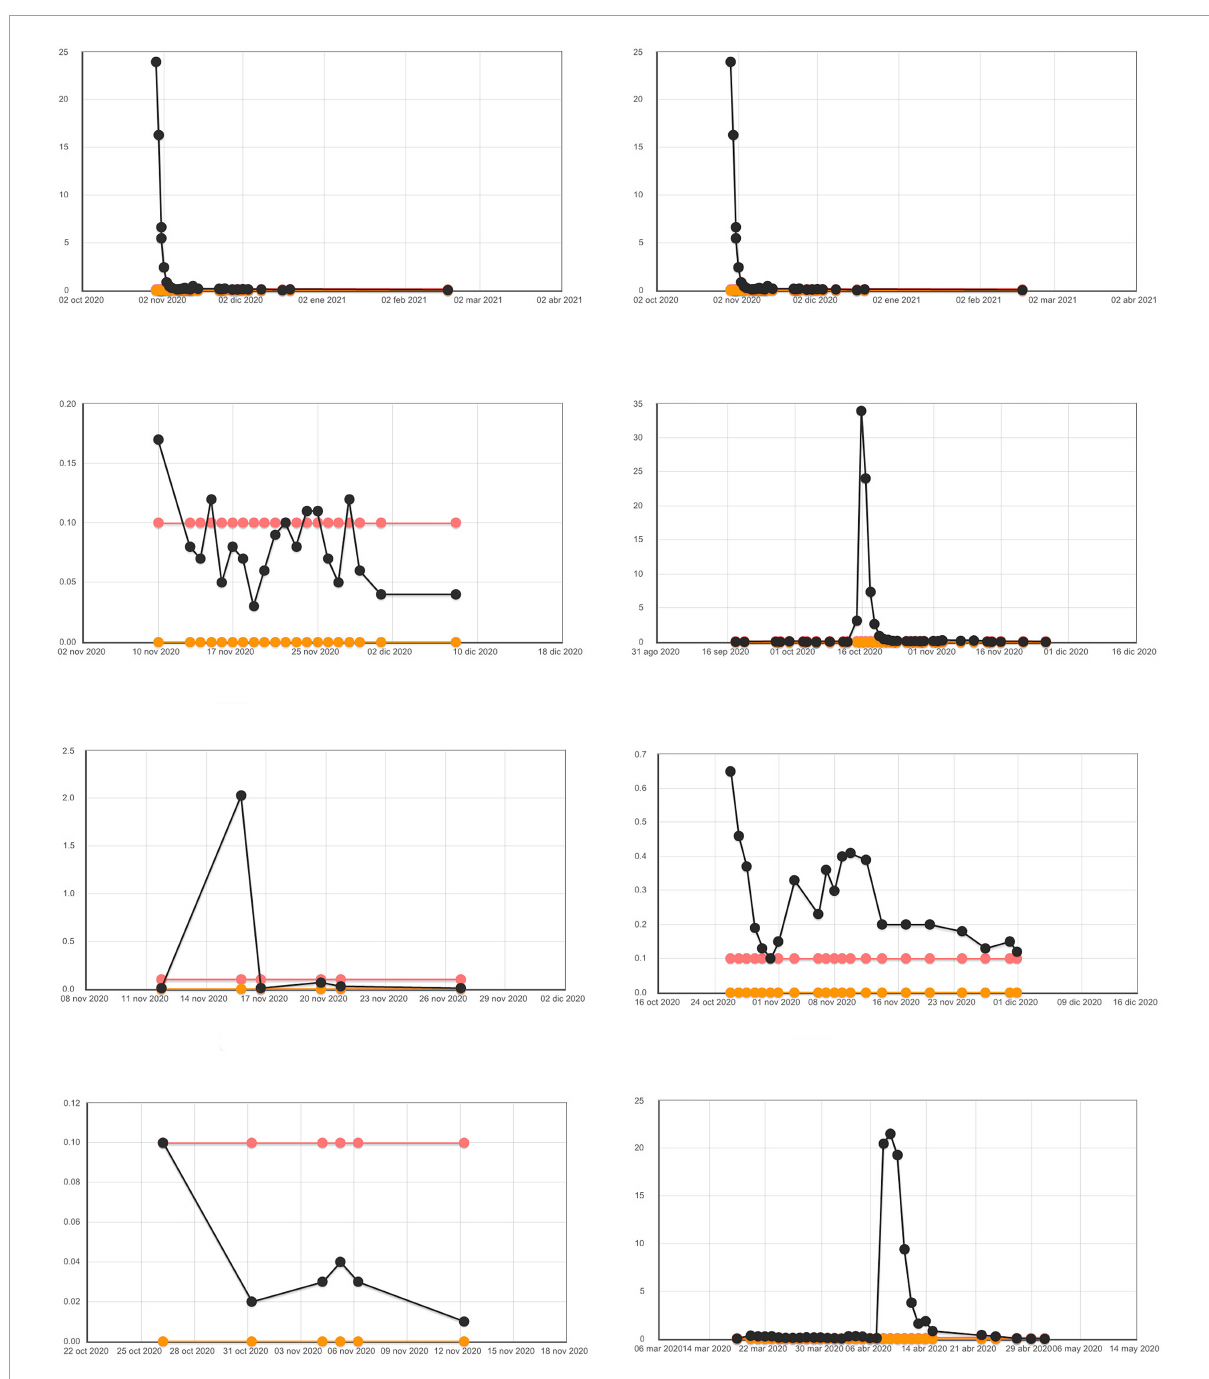
FIGURE2 Evolution of PCT during all days of ICU stay in patients who lived [lower and upper normal range of laboratory (0–0.05 ng/ml)]. We have considered the value of PCT higher than 0.5 ng/ml as clinical significance.